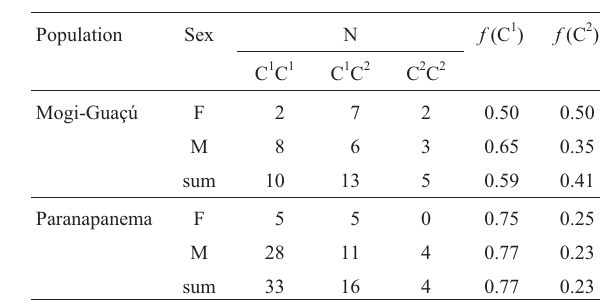
Table 2 - Chromosome variants (C 1 and C 2 ) in both sexes (F, females and M, males) detected in Leporinus elongatus in both studied populations. N = number of individuals; f =